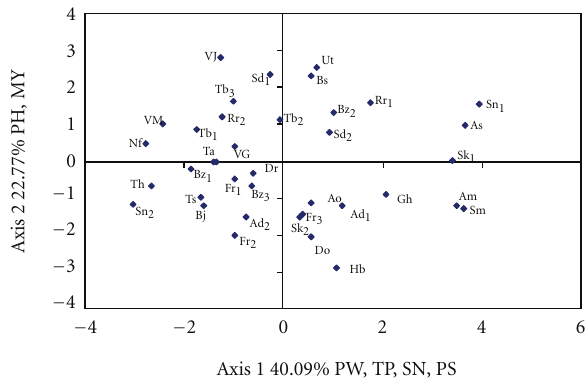
Figure 2: First 1-2 plan of the principal component analysis per- formed on 35 spontaneous populations and 3 cultivars of tall fescue and based on 9 agronomic variables. Populations and parameters abbreviations are summarized in Table 1 and Table 2,